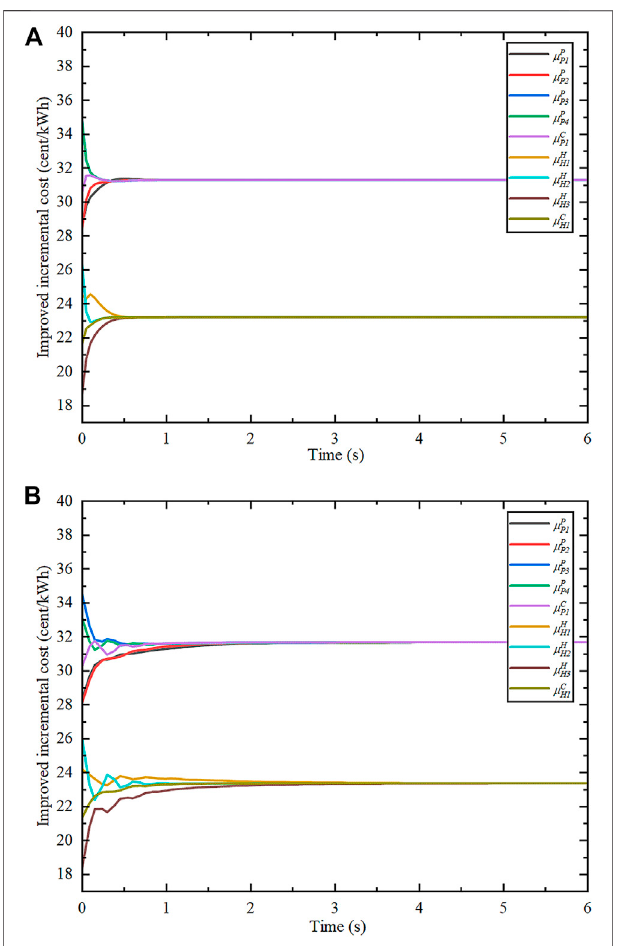
FIGURE 8 | Comparison of the convergence speed of the two algorithms. (A) The algorithm proposed in this paper. (B) The algorithm proposed in (Chen and Li,